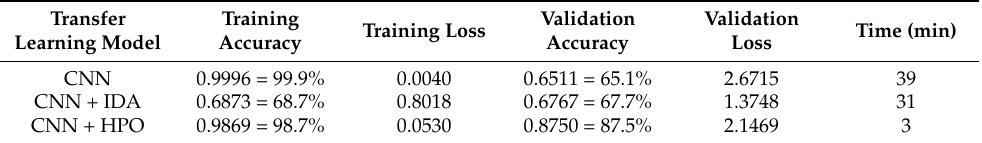
Table 8. Summary of CNN results. Transfer Learning Model